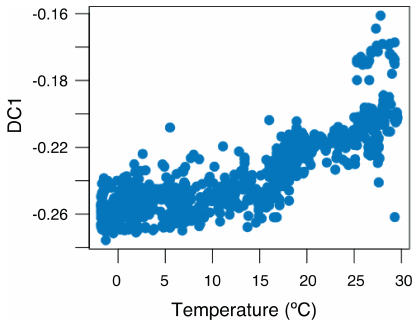
Figure 9. The first diffusion component as a function of tempera- ture (modern data